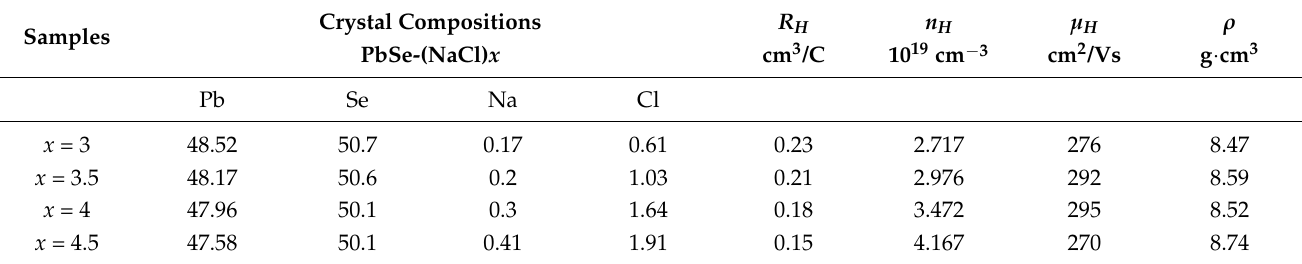
Figure 2. The micro characterization of PbSe(NaCl) 3 with high crystal quality. ( a ) FESEM image, ( b ) EDS image, ( c ) HRTEM image, ( d ) SAED image. Table 1. A list of samples and some of their temperature-dependent properties at 300 K.